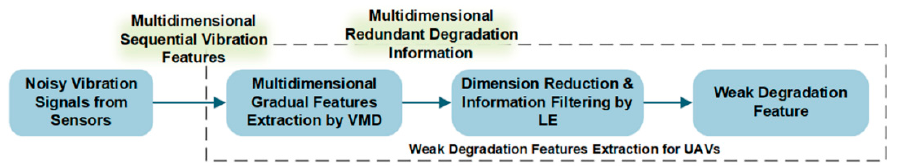
Figure 1. Principle and flowchart of the proposed method.